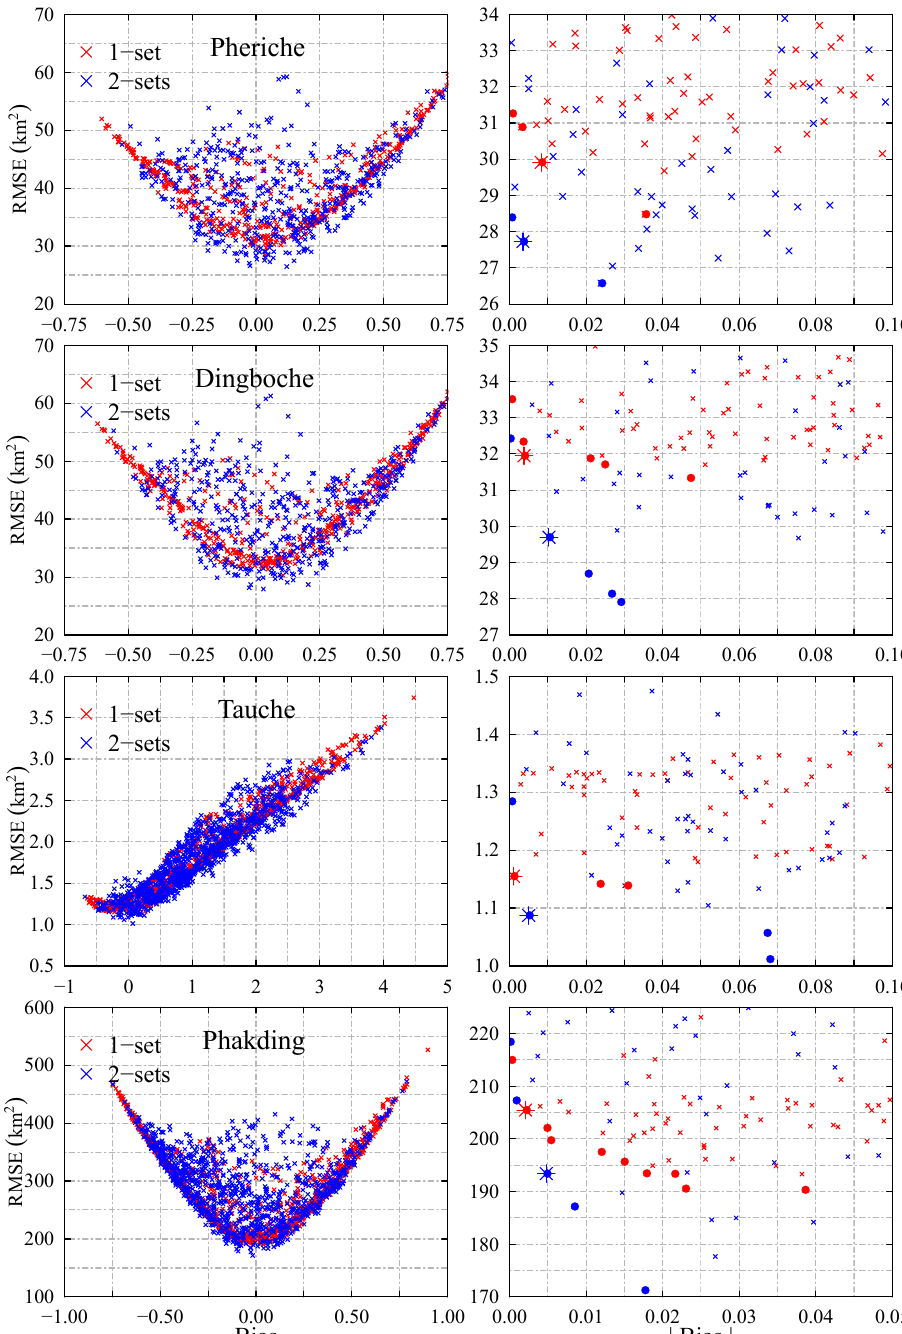
Figure 9. Performances of the simulated SCA. The data used as references were the processed MOD10A2 SCA. The left part of the figure shows all the simulations for the four sub-basins inside the solution area (RMSE and relative bias). The right part shows a closer view of the most performant solutions for each basin. The dots represent the Pareto front and the stars indicate the selected solution.